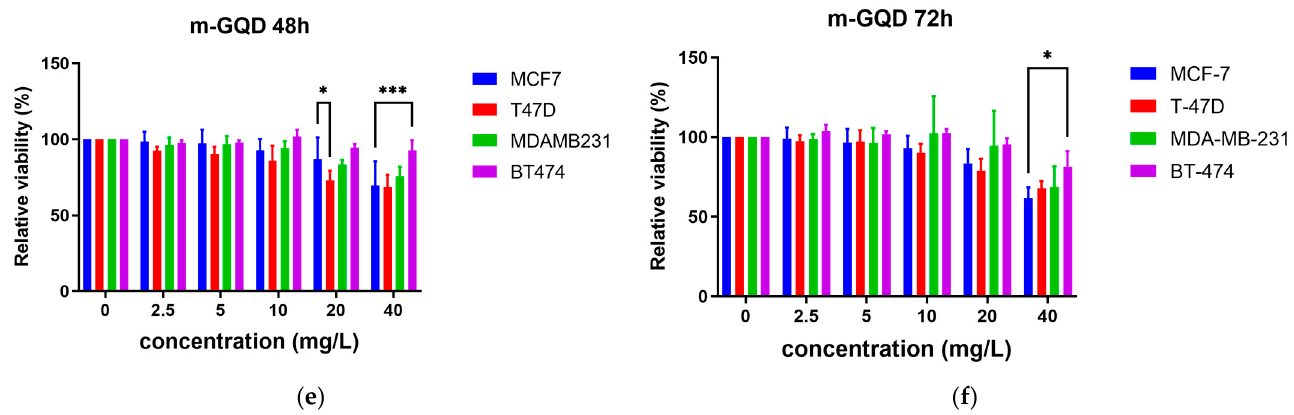
Figure 2. Relative cell viability of four breast cancer cell lines MCF-7, T-47D, MDA-MB-231, and BT-474 ( a ) treated with GQD (1:3) for 48 h; ( b ) treated with GQD (1:3) for 72 h; ( c ) treated with o-GQD for 48 h; ( d ) treated with o-GQD for 72 h; ( e ) treated with m-GQD for 48 h; and ( f ) treated with m-GQD for 72 h, as determined using MTT assay. The data indicate averages from triplicates, and the error bars indicate SD. Significance is determined by using two-way ANOVA statistical analysis. The significant differences are indicated by using *. *: p < 0.05, **: p < 0.01, ***: p < 0.001, ****: p < 0.0001.